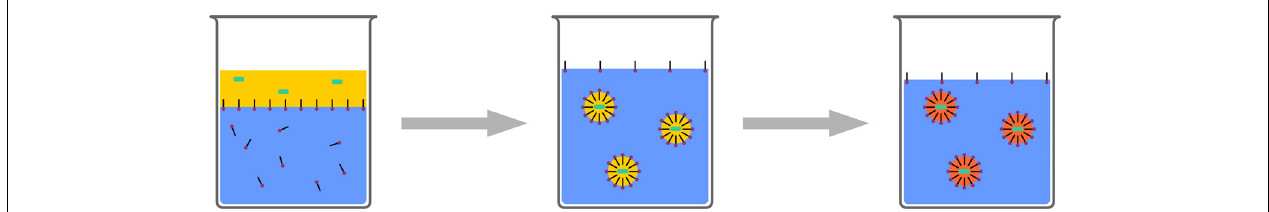
FIGURE 6 | Schematic representation of miniemulsion polymerization. Stable droplets in the range of few hundreds of nanometers are generated by the addition of a costabilizer (light green) and homogenization by ultrasound. The monomer droplets act as nanoreactors.